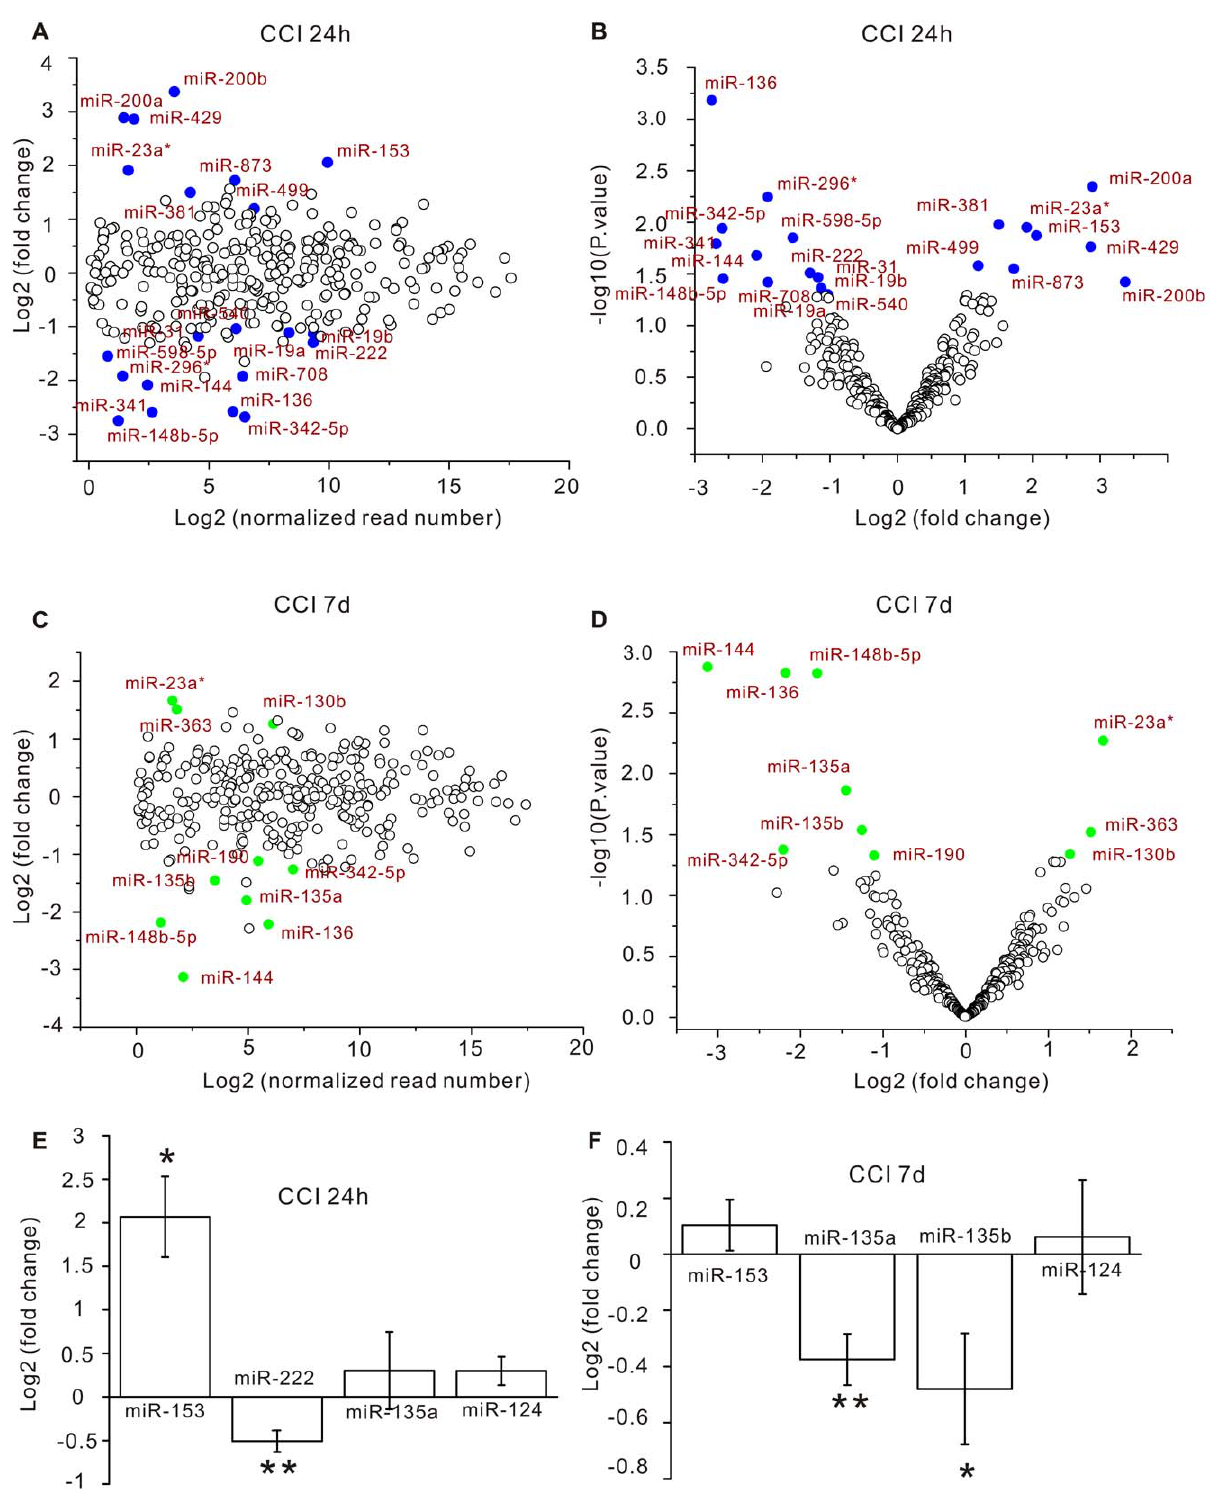
Figure 1. miRNA expression changes in the CCI brains. The hippocampus on the operated side of the brain was removed for miRNA expression profiling by deep sequencing at 24 hours (A, B) and 7 days (C, D) after CCI. Each circle represents a miRNA species. (A, C) The fold change (on log2 scale) of each miRNA species in CCI rats versus sham controls is plotted against its normalized read number (on log2 scale). (B, D) The p-value (on log10 scale) of each miRNA species is plotted against its fold change (on log2 scale). Blue and green dots are miRNAs that have p-values less than 0.05. (E, F) The fold change (on log2 scale) of miRNAs analyzed by qRT-PCR. Data are presented as mean 6 s.e.m. Student’s t test was used for statistical analysis. * p , 0.05; ** p , 0.01.